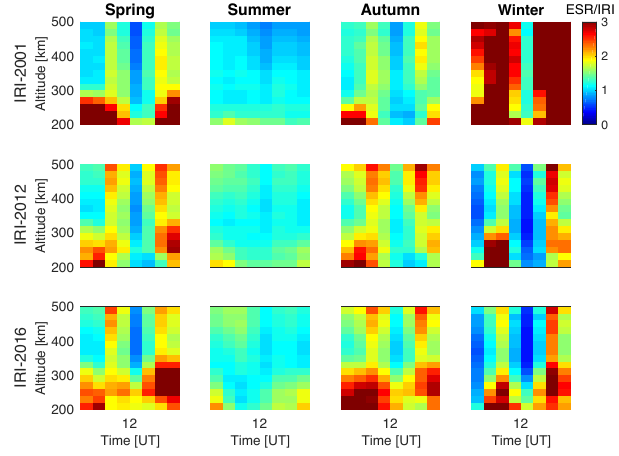
Figure 5. Same as Fig. 4, but for 2008, in the extended solar mini- mum, instead of